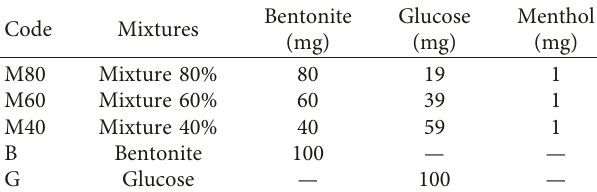
Table 1: Composition of the studied